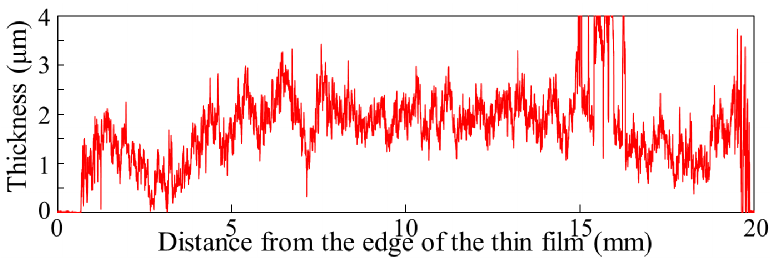
Figure 3. Surface roughness measurement results of the Mg(OH) 2 film.